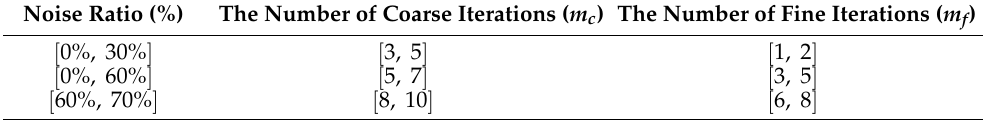
Table 2. Iterations to be performed on coarse and fine stages. Noise Ratio